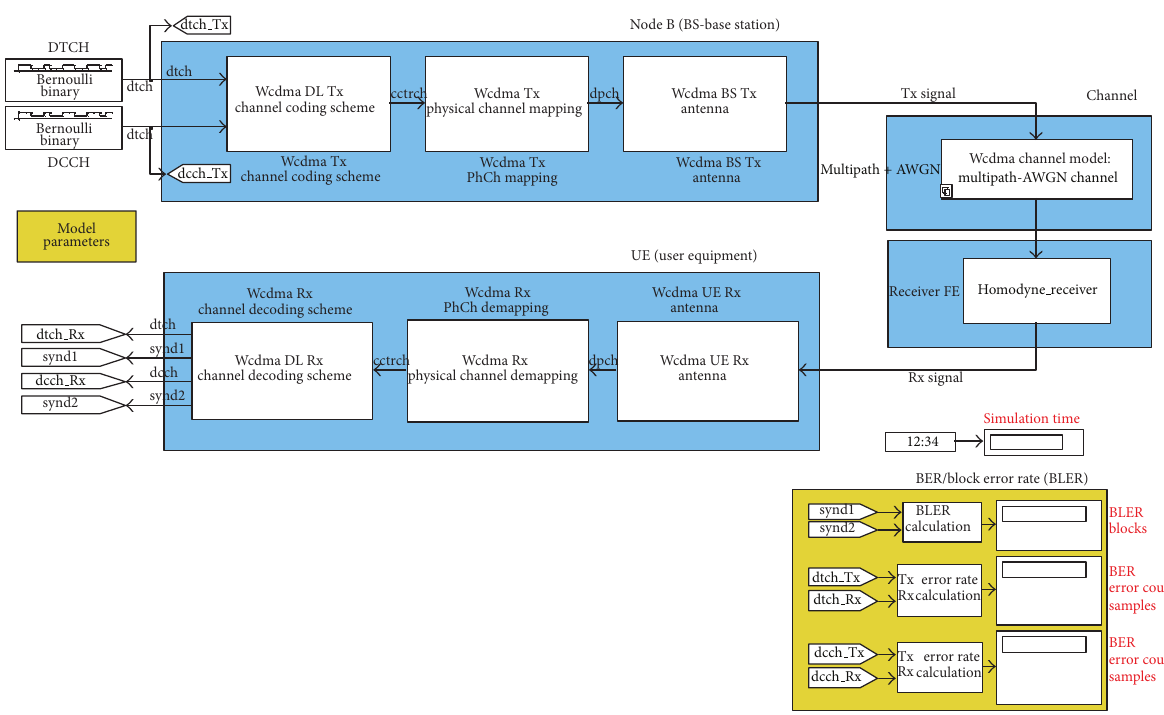
Figure 3: MATLAB Simulink WCDMA end-to-end physical layer demo.